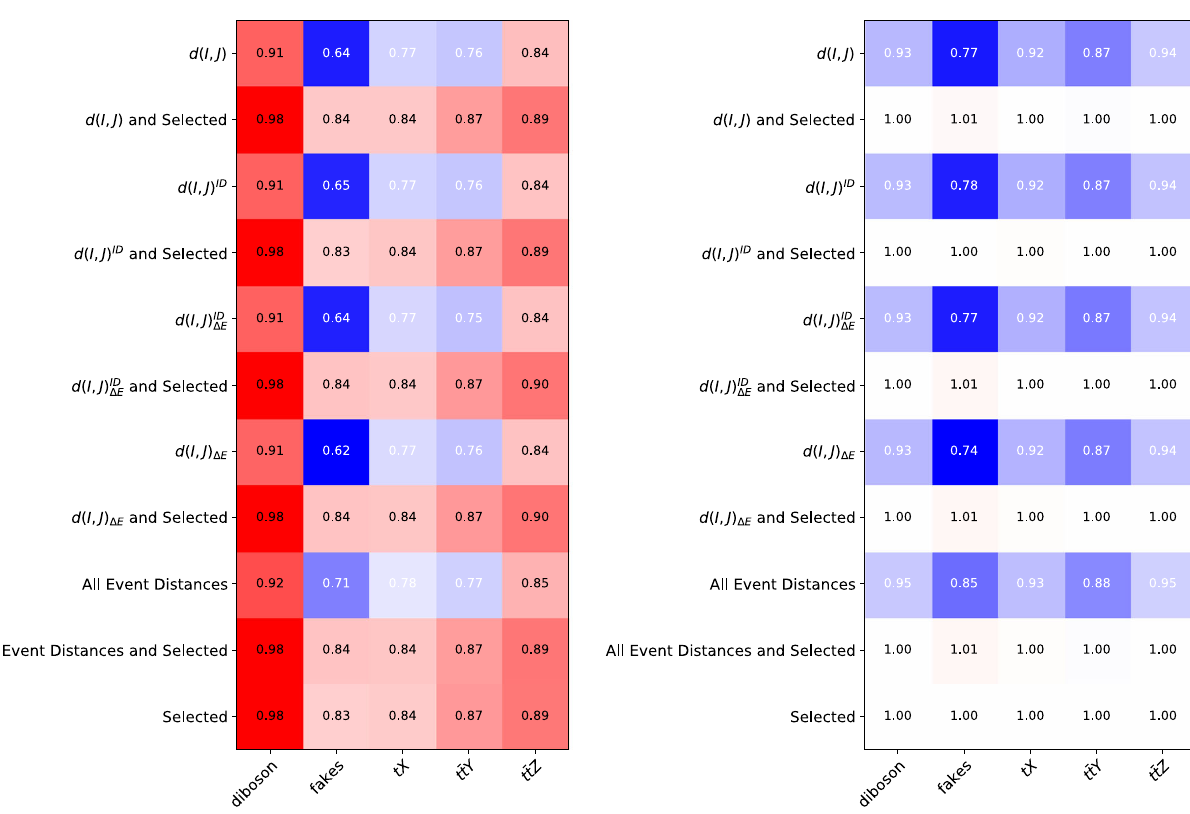
Fig. 7 Areas under the ROC curves for all signals for all feature combinations. The left figure shows the obtained values for the areas under the ROC curves while in the right one the values were normalized to the values obtained for the baseline of selected reconstructed features (last row)